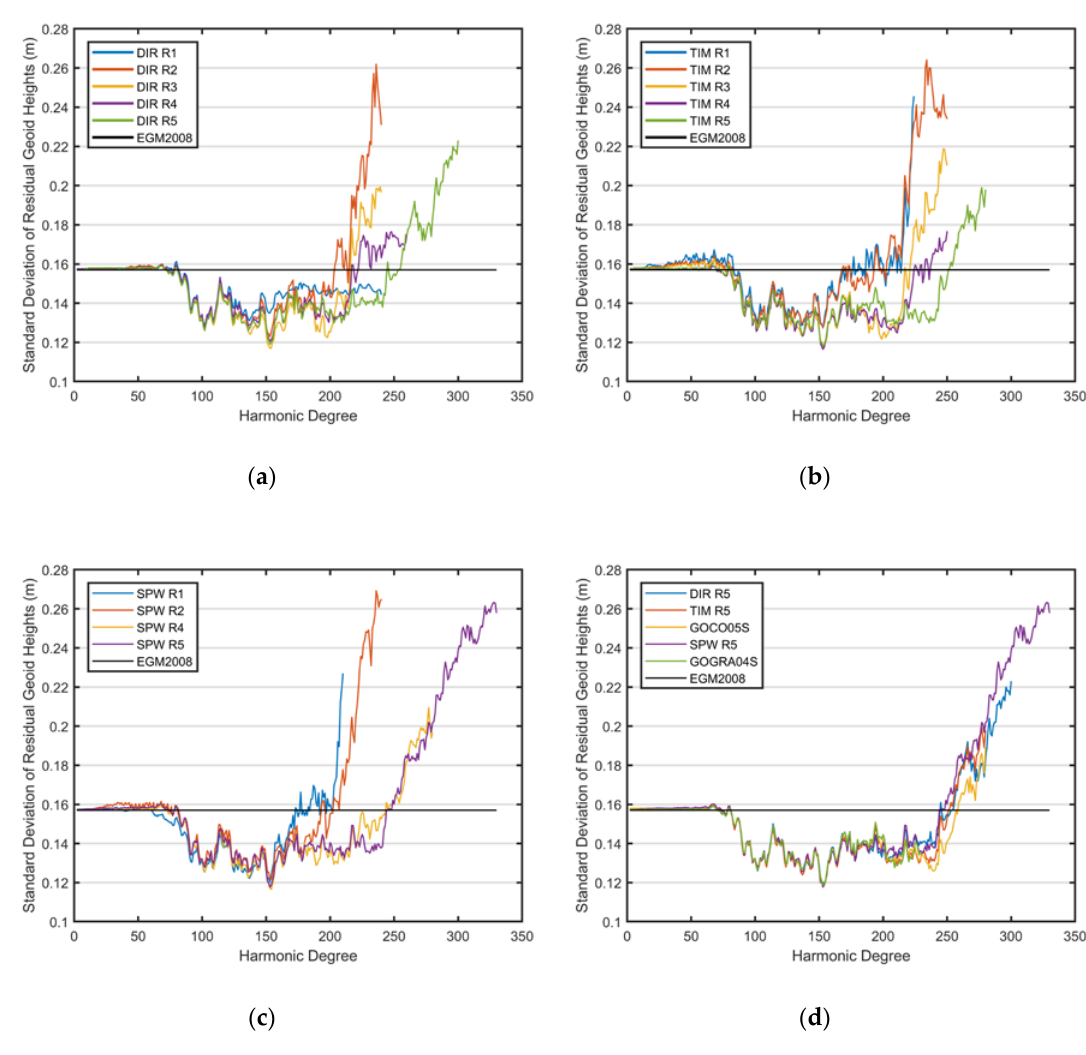
Figure 5. Validation of GGMs regarding the standard deviations of the geoid undulation residuals ( N GPS / lev . − N enh . ) in meters (Dataset II): ( a ) DIR RLx models; ( b ) TIM RLx models; ( c ) SPW RLx models; ( d ) comparison among the last versions of the satellite-based and combined models.